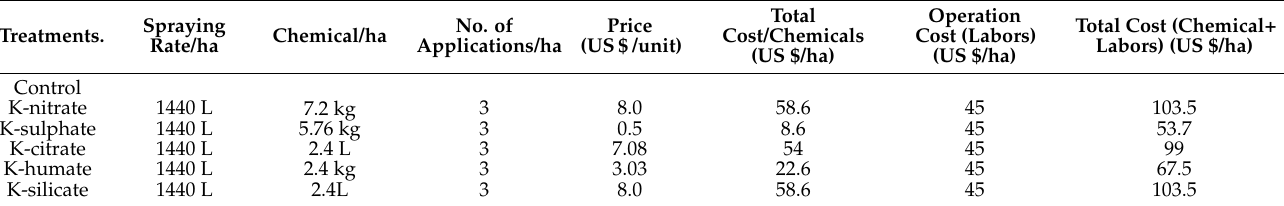
Table 10. The costs of the treatment of foliar application by potassium salts.